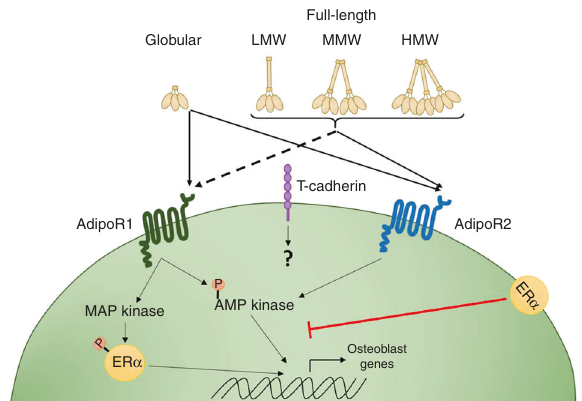
Fig. 1 Adiponectin signalling. The full-length adiponectin protein can be cleaved into smaller active components, which circulate either as it ’ s globular domain 7 or as full-length homo-complexes — low molecular weight (LMW) trimers, medium molecular weight (MMW) hexamers or high molecular weight (HMW) oligomers. 8 – 10 Adiponectin can bind to two classical adiponectin receptors 1 and 2 (AdipoR1 and AdipoR2) 14,15 leading to downstream signalling through several pathways, primarily driving AMP kinase (AMPK) and to a lesser extent activating MAP kinase (MAPK). 16 – 18 Expression of the oestrogen receptor (ER α ) appears to skew adiponectin receptor signalling to primarily trigger the MAPK pathway, 61 which in turn phosphorylates both ER α and transcription factor SP1, altering downstream signalling. AdipoR1 has a higher af fi nity for the globular domain of adiponectin, whilst AdipoR2 displays an intermediate af fi nity for all adiponectin isoforms. 21 In addition to the classical adiponectin receptors, HMW and MMW adiponectin can also interact with T-cadherin (cadherin-13; CDH13), 19,20 although the downstream signalling and functional outcomes from